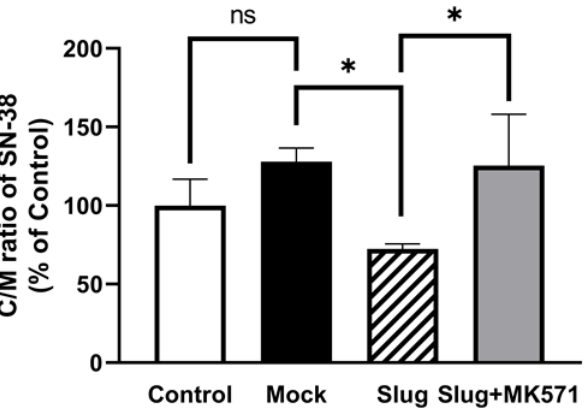
Figure 5. SN-38 uptake assay using 2 µ M SN-38. The SN-38 in Slug-transfected cells showed